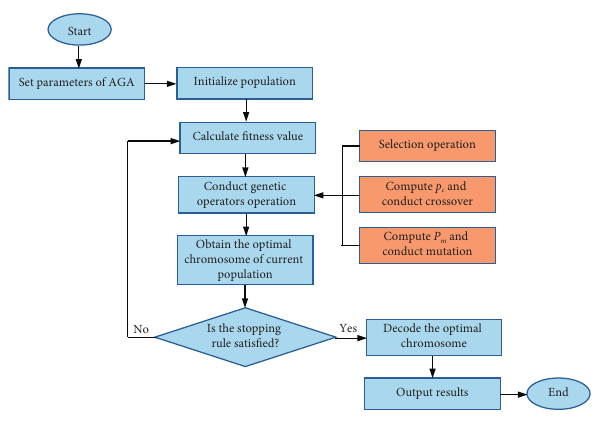
Figure 5: Flowchart of